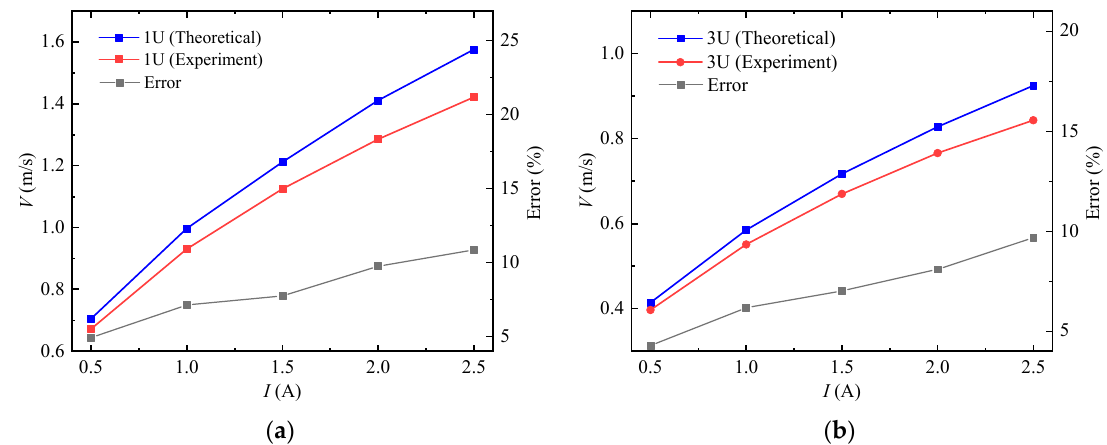
Figure 27. Separation speed: ( a ) 1U CubeSat and ( b ) 3U CubeSat.